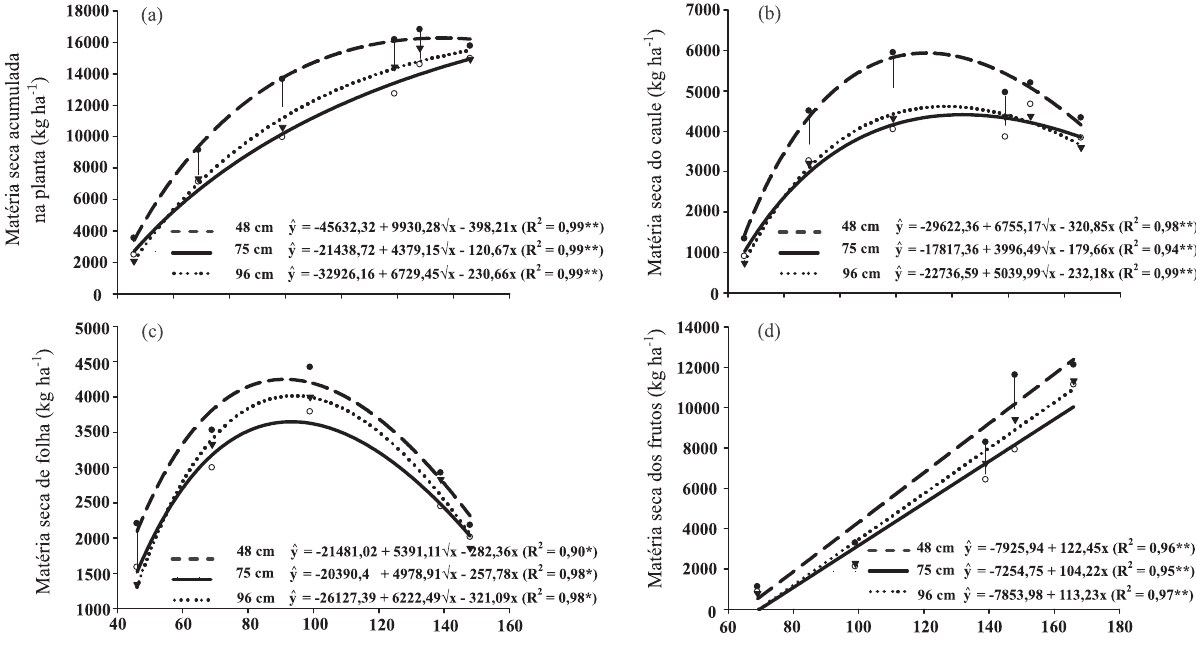
figura 1. Acúmulo de matéria seca da planta (a), do caule (b), das folhas (c) e dos frutos (d) do algodoeiro cultivado nos espaçamentos de 48 ( ), 75 ( ) e 96 cm ( ). A barra vertical representa a diferença mínima significativa (dms p <